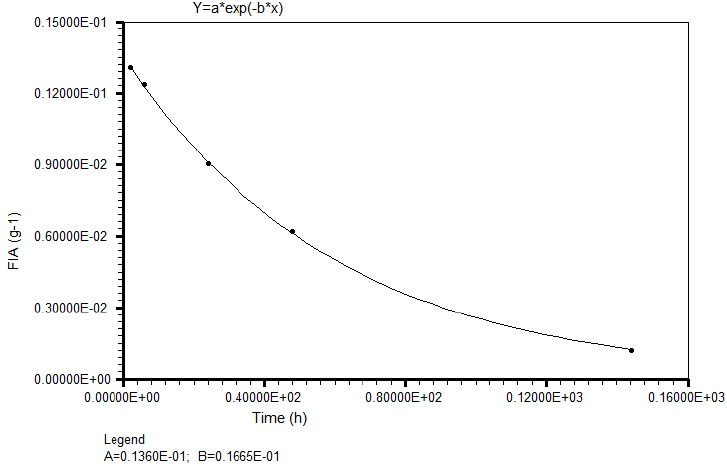
Figure 3. Mono-exponential fit of FIA BL values vs. time after administration.